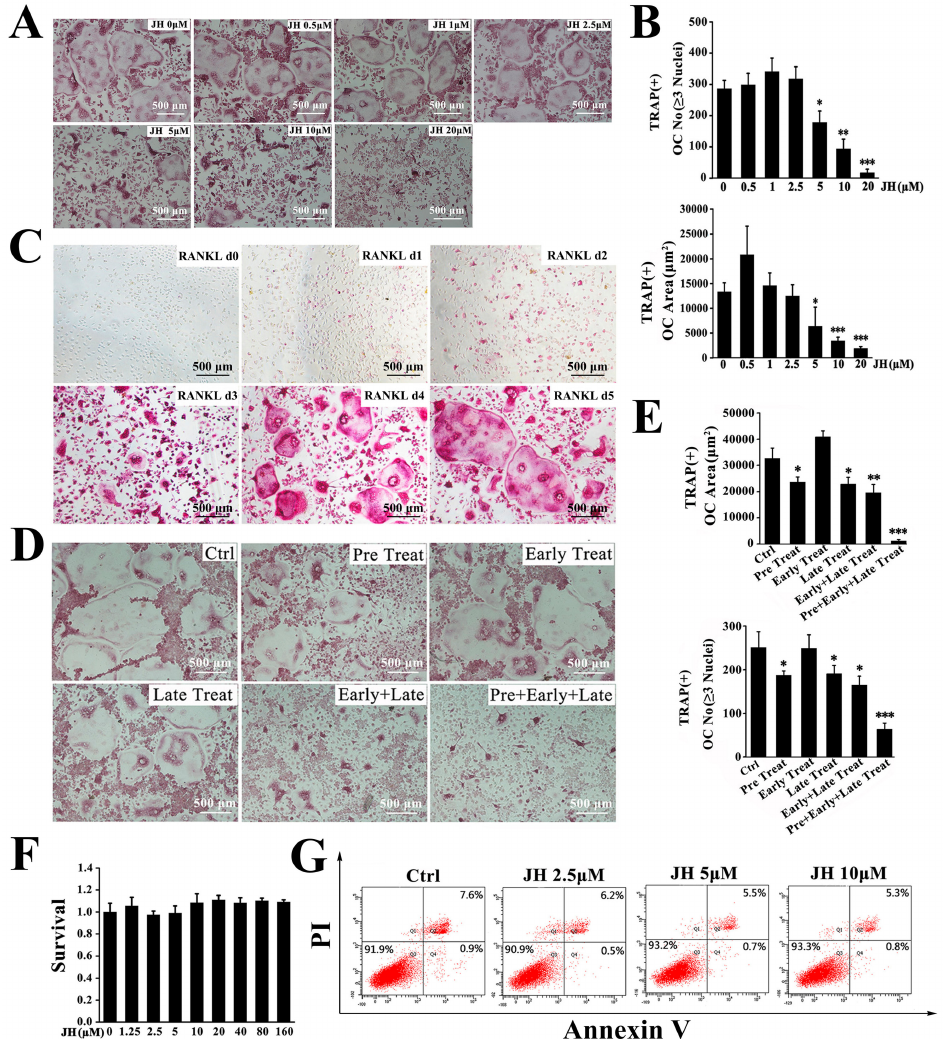
Figure 3. JH inhibits osteoclast formation in vitro. ( A ) A representative image showing the inhibitory effect of JH on osteoclast formation. BMM cells were treated with different concentrations of JH in the presence of RANKL (100 ng · mL − 1 ) for 5 days and then TRAP staining was performed. The number and area of TRAP + multinucleated cells with more than three nuclei were shown in ( B ), n = 3, * p < 0.05, ** p < 0.01 and *** p < 0.001 relative to RANKL-treated, JH-untreated controls. OC No: osteoclast number. ( C ) To define the different stages of osteoclastogenesis, TRAP staining was performed on d0–d5 of RANKL induction (d0, the day RNAKL was added; d1, RANKL induction for 1 day; d2, RANKL induction for 2 days; and so on). ( D ) BMMs were cultured in the presence of RANKL, and JH (5 µ M) was added in different times. At the end of 5 days, TRAP staining was performed. (Ctrl group: RANKL induction for 5 days without JH; Pre Treat group: JH pre-treatment for 12 h and RANKL induction for 5 days; Early Treat group: Co-treatment with JH and RANKL for 2 days and RANKL continued induction for 3 days; Late Treat group: RANKL induction for 2 days and subsequent co-treatment with JH and RANKL for 3 days; Early + Late Treat group: Co-treatment with JH and RANKL for 5 days; Pre + Early + Late Treat group: JH treatment for 12 h and subsequent co-treatment with JH and RANKL for 5 days) ( E ) The area and number of TRAP + osteoclasts ( ≥ 3 nuclei) from ( D ) were quantified ( n = 3). All data were shown as mean ± SD; * p < 0.05, ** p <0.01 and *** p < 0.001 relative to RANKL-treated, JH-untreated controls. ( F ) Effect of JH on cell viability was measured using a MTS assay. ( G ) BMMs were exposed to the indicated concentrations of JH for 24 h, and then cell apoptosis was determined using flow